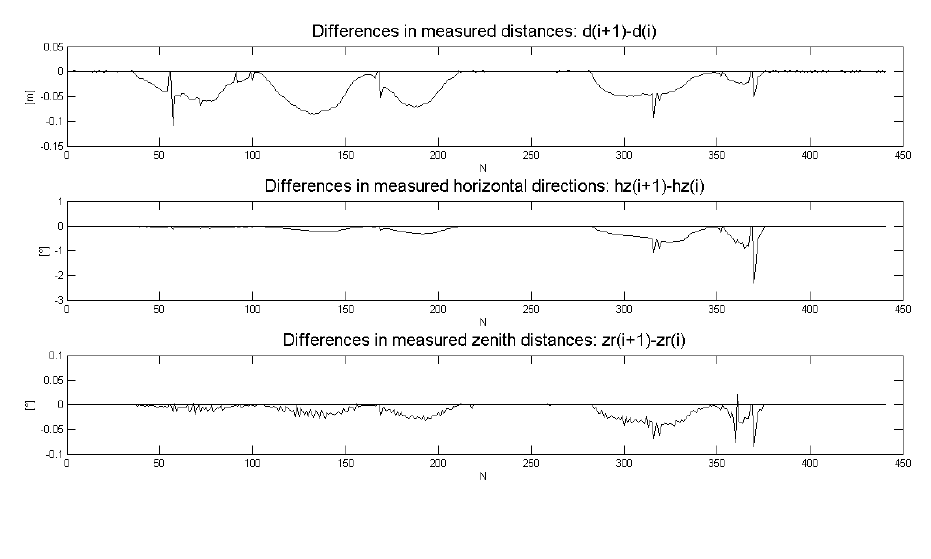
Figure 9. Indirect or KF